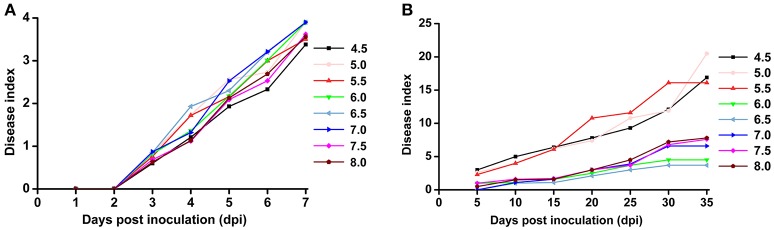
Bacterial wilt disease development under different pH conditions. (A) Indoor pot experiment. Six-week-old tobacco seedlings (Yunyan 97) grown in autoclaved soil medium with different pH were inoculated with wild-type R. solanacearum strain CCT011 by soil drenching. Disease progression was recorded daily using a 0 to 4 disease index scale (0, no symptoms; 1, 1 to 25% of leaves wilted; 2, 26 to 50% of leaves wilted; 3, 51 to 75% of leaves wilted; 4, 76% to 100% of leaves wilted). Each point represents the average disease index of 15 plants. (B) Field pot experiment. Tobacco plants (Yunyan 97) grown in natural field soils with different pH were inoculated with R. solanacearum CCT011 by soil drenching. Disease symptoms were recorded every fifth day using a disease index scale of 0 to 9 (0, no wilt symptoms; 1, less than half of the leaves on disease side wilted; 3, half to two-thirds of the leaves on disease side wilted; 5, more than two-thirds of the leaves on disease side wilted; 7, all the leaves on disease side wilted; 9, the whole plant died). Each point represents the average disease index of 15 plants.